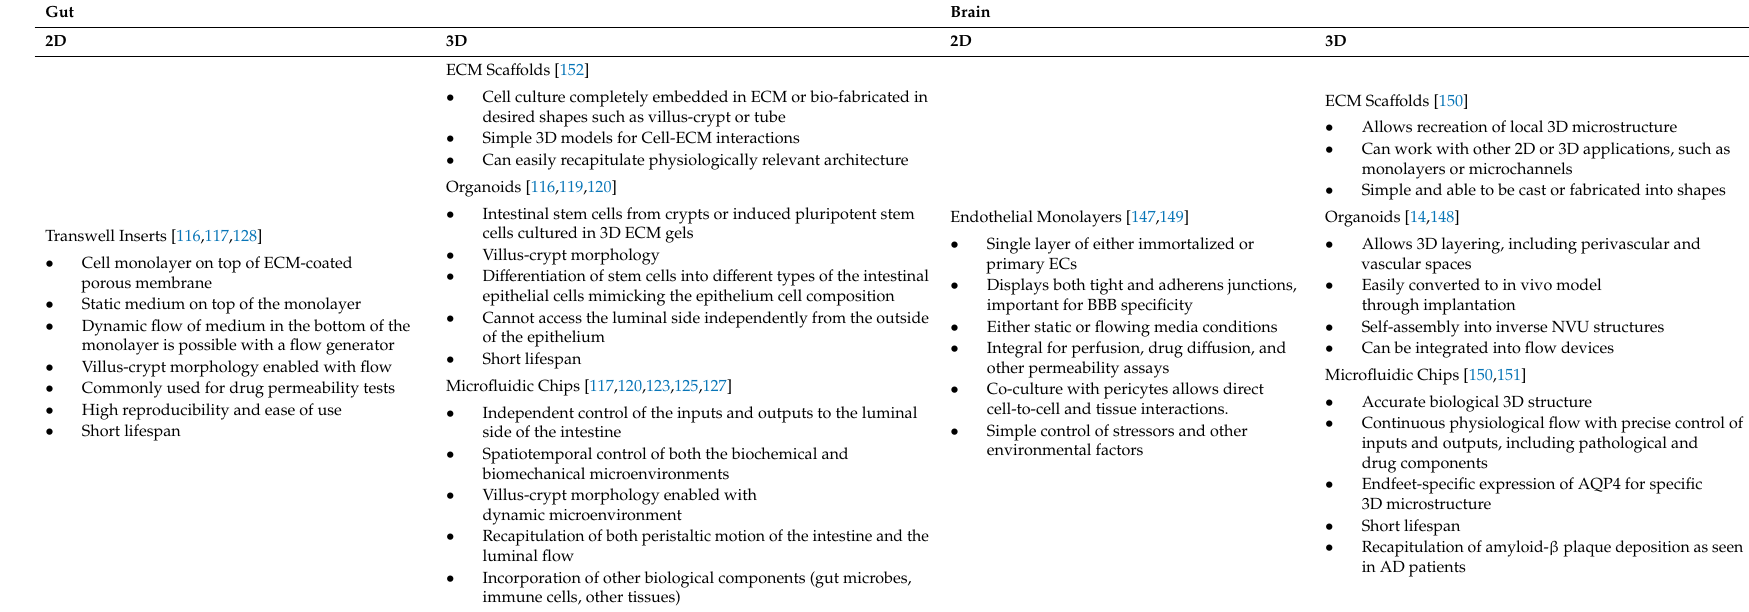
Table 1. Two-dimensional (2D) vs. three-dimensional (3D) in vitro